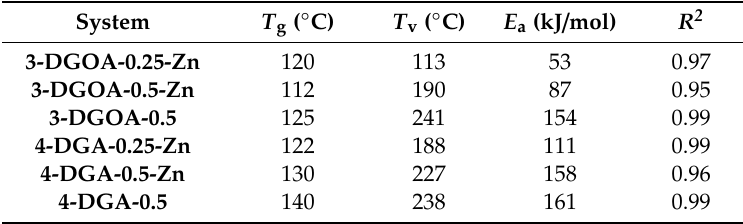
Table 2. Characteristic properties of epoxy-anhydride vitrimers under investigation: T g values derived from dynamic-mechanical thermal analysis DMTA measurements and T v and E a data obtained from Arrhenius plots, in which R 2 denotes the coe ffi cient of